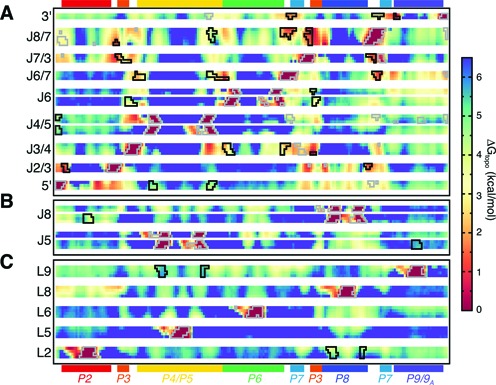
The ΔGtopo of forming different pairwise tertiary contacts in the Azoarcus ribozyme. All residues are shown along the x-axis, with selected single-stranded regions grouped along the y-axis according to whether they (A) participate in A-minor and base-triple interactions, (B) are tetraloop-receptors or (C) are tetraloops. Regions outlined in black correspond to bona fide long-range tertiary interactions. Regions that are proximal in the native structure but do not interact are outlined in gray.